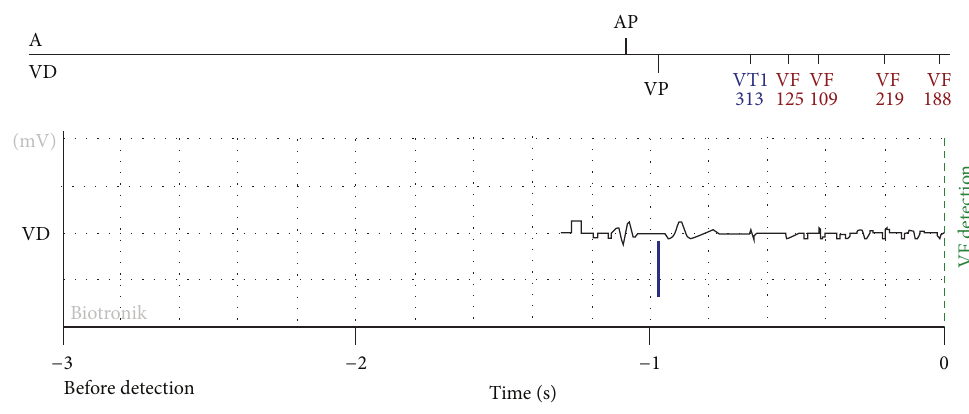
Figure 1: Intracardiac EGM as available from the website of the home-care ICD telemonitoring system.